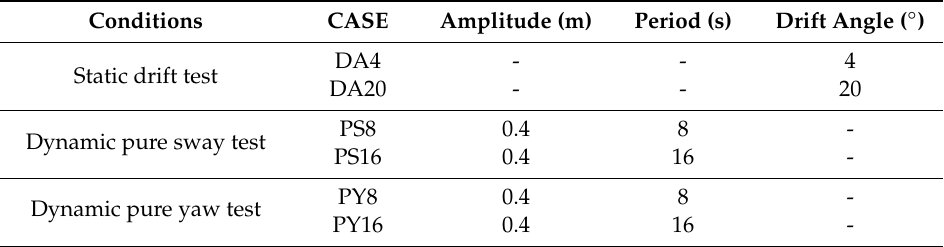
Table 2. Summary of the tests and calculated conditions.